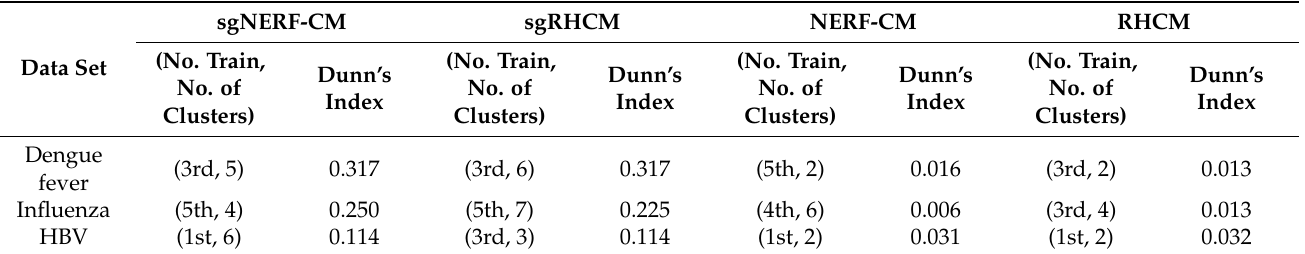
Table 6. The best result from age